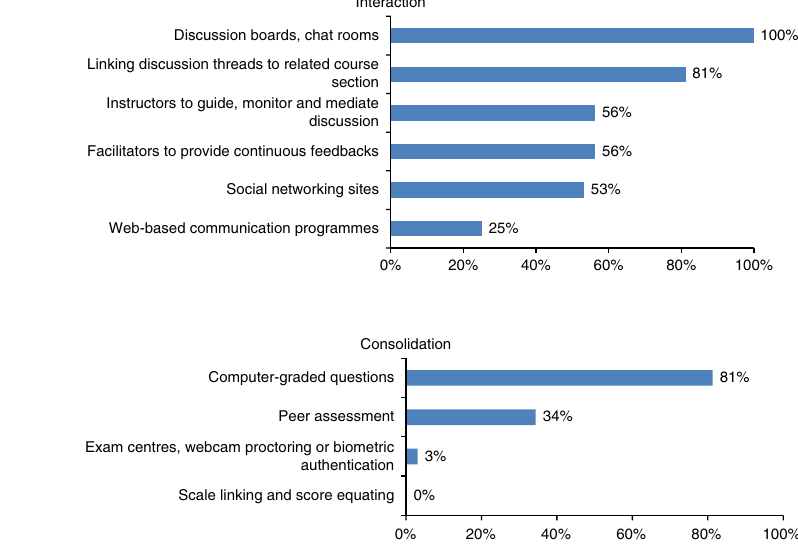
Figure 3. Presence of factors in the interaction stage